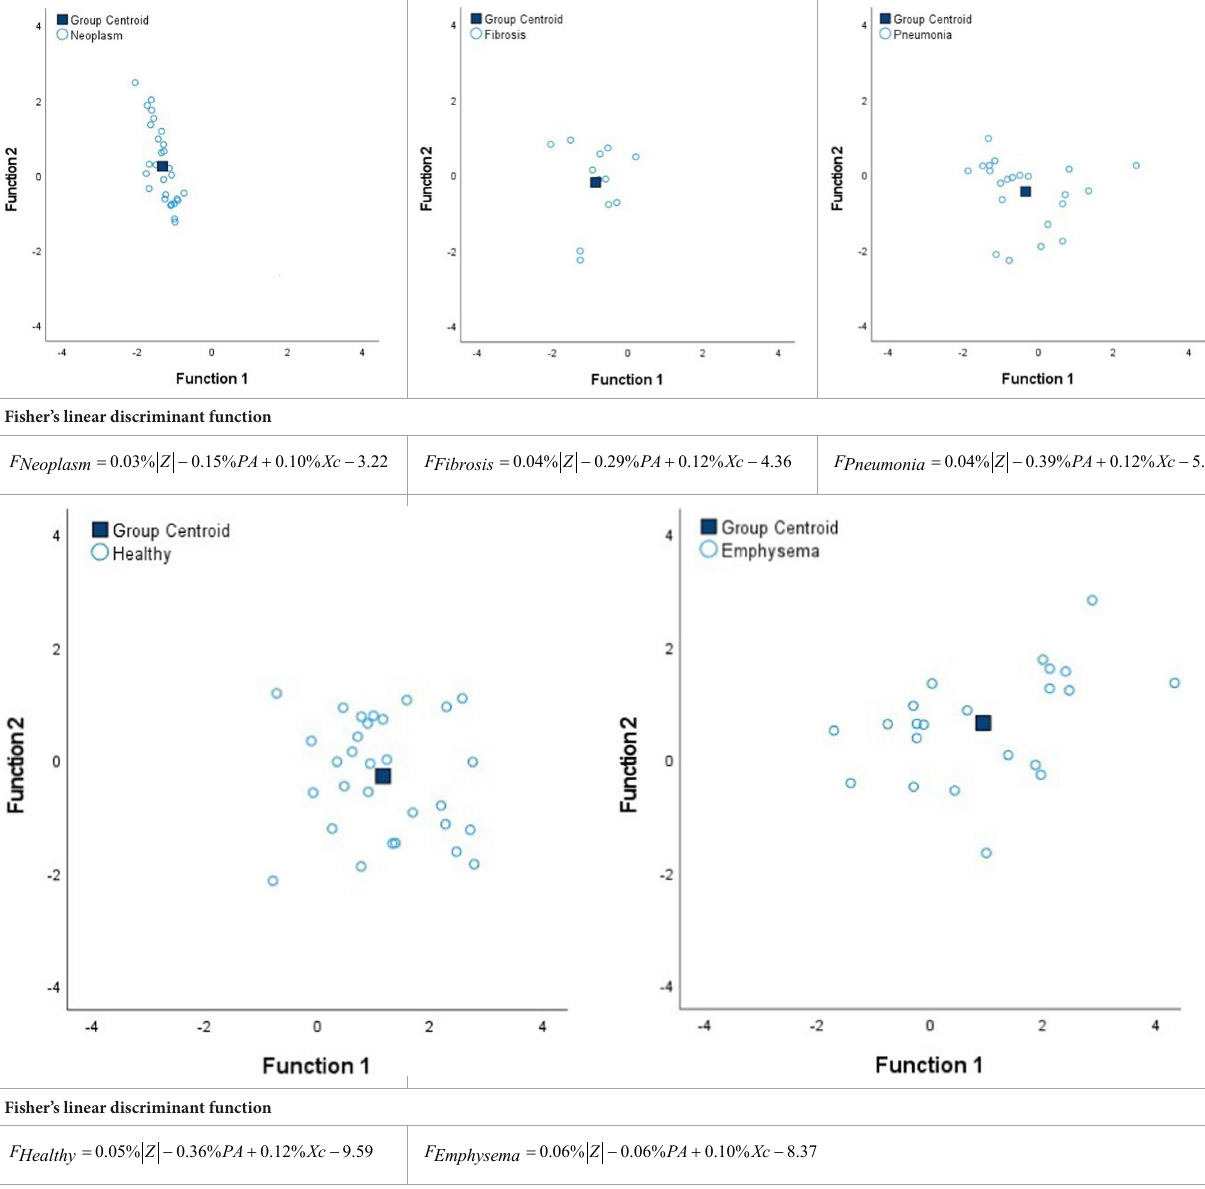
Fisher’s linear discriminant